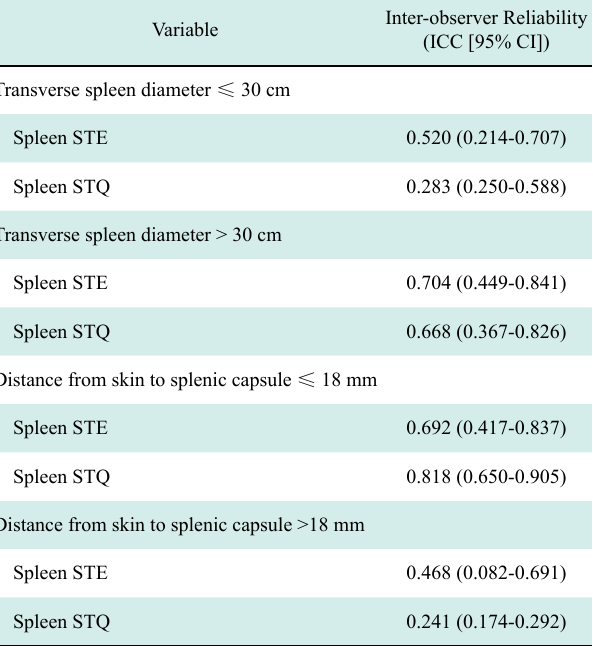
Table 3 Spleen stiffness subgroup analysis of inter-observer reliability